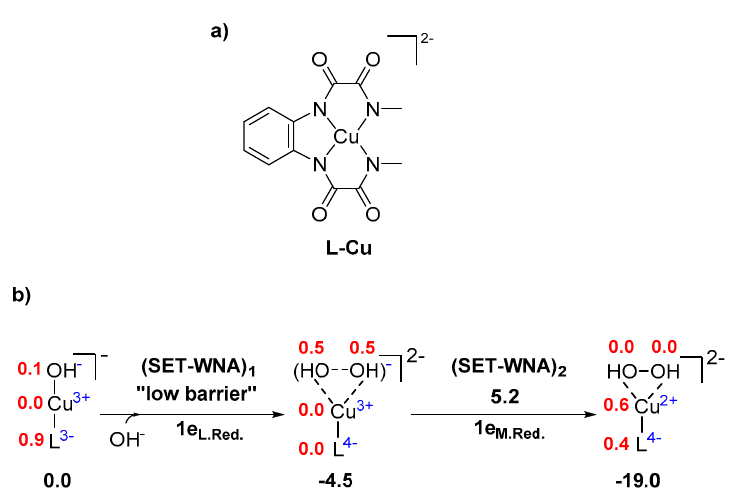
Figure 1. ( a ) The catalyst under study in this work. ( b ) single-electron transfer–water nucleophilic attack mechanism reported in [41]. Free energies (kcal/mol) in black, spin populations in red.